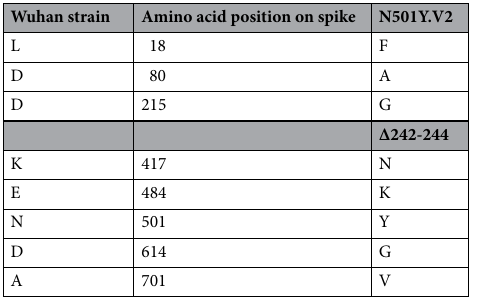
Table 1. List of mutations introduced in the Wuhan strain to make the N501Y.V2